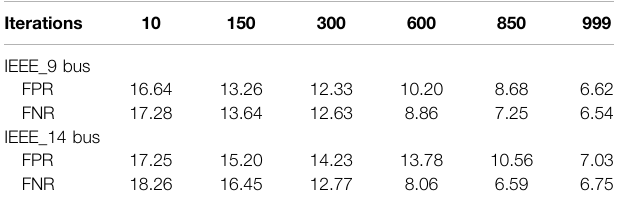
TABLE 2| PerformanceofOneClassSupport VectormachinesonData-set (IEEE 9-bus and 14-bus).